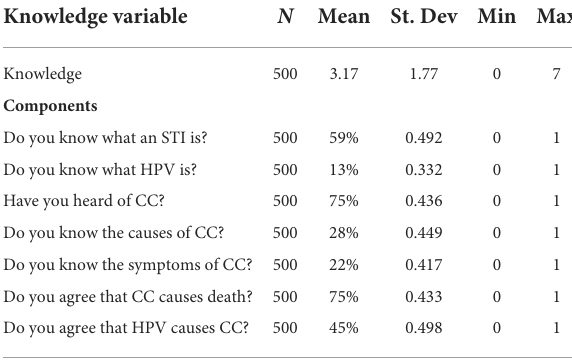
TABLE 1 Descriptive statistics for knowledge